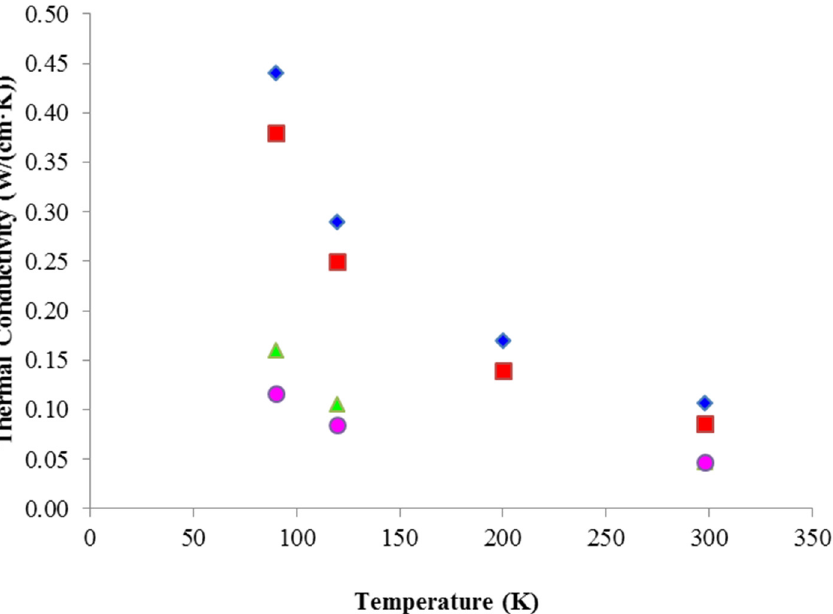
Figure 17. Thermal conductivity as a function of absolute temperature for the a (red [3]) and c (blue [3]) axes of the undoped uniaxial material GdVO 4 , the b -axis (green) of the biaxial material YSO [30], and the anaxial material GSAG (pink) [30].